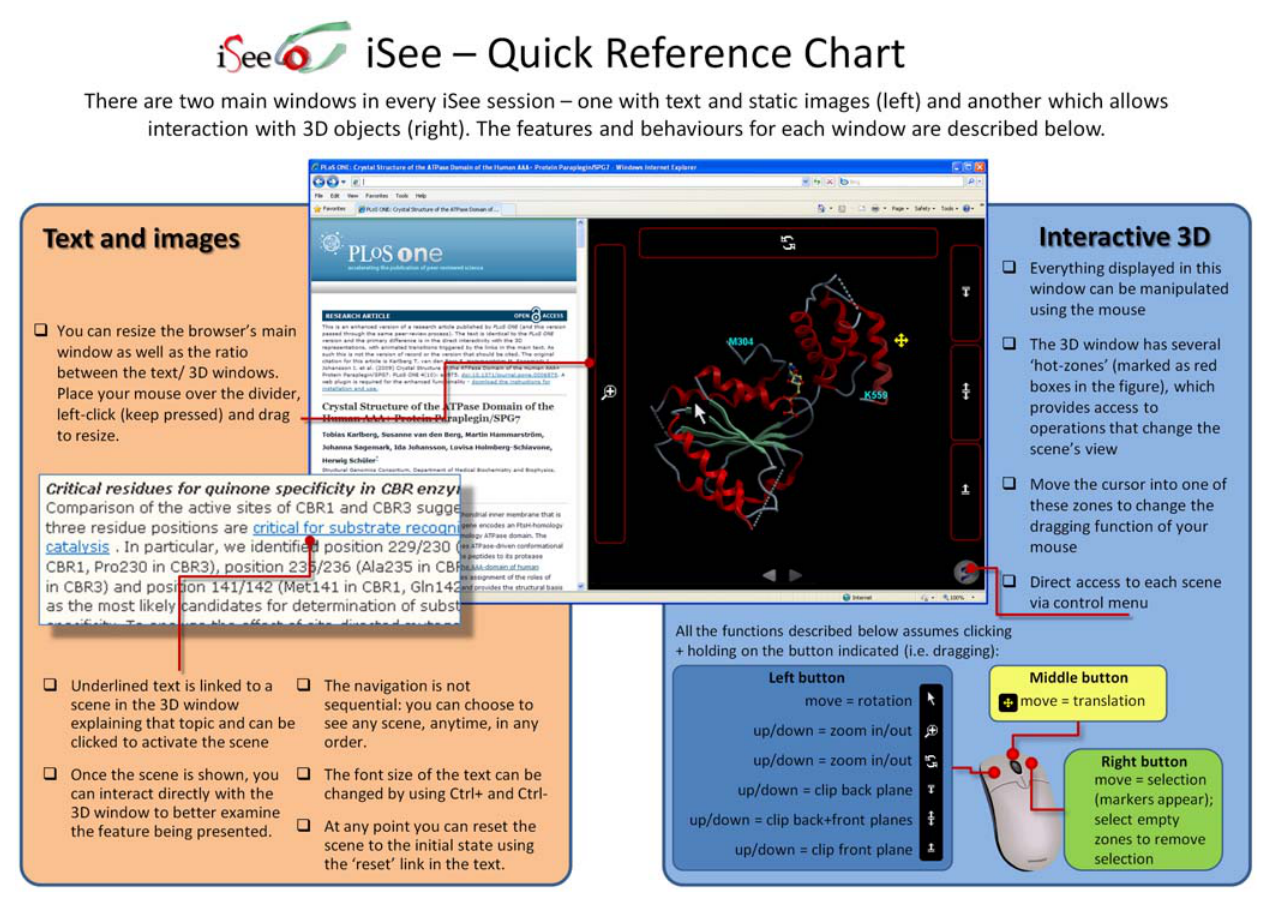
Figure 3. Main features of the enhanced iSee version of the articles and a quick reference guide to interact and use the graphical display window. Both on-line and offline (standalone) versions of the enhanced iSee articles have the same controls and